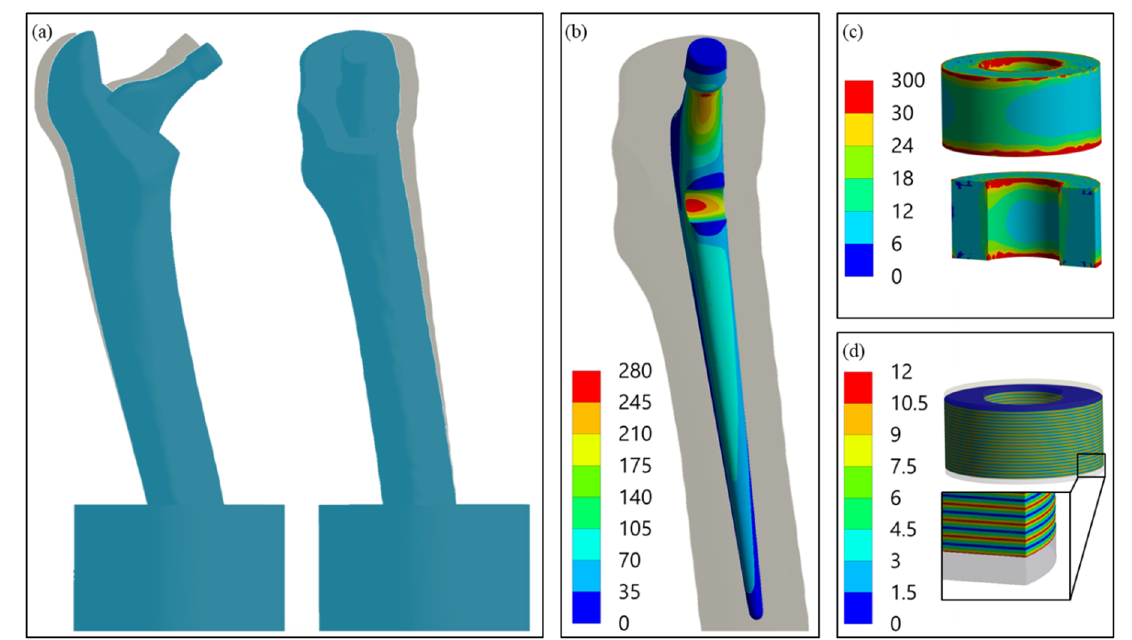
Figure 5. ( a ) Deformation of the whole system with non-deformed geometry in the background, 10-fold scaling for clarity, postero-anterior view (left) and latero-medial view (right); ( b ) Von Mises stress distribution (MPa) in the modified implant geometry with maximum at the introduced cavity base; ( c ) Von Mises stress distribution (MPa) in the piezoelectric element with a cross-sectional view, areas of excessive stress due to contact boundary conditions are shown in red; ( d ) electric potential distribution (V) in the active piezoelectric multilayer component with a cross-sectional view of the detail.